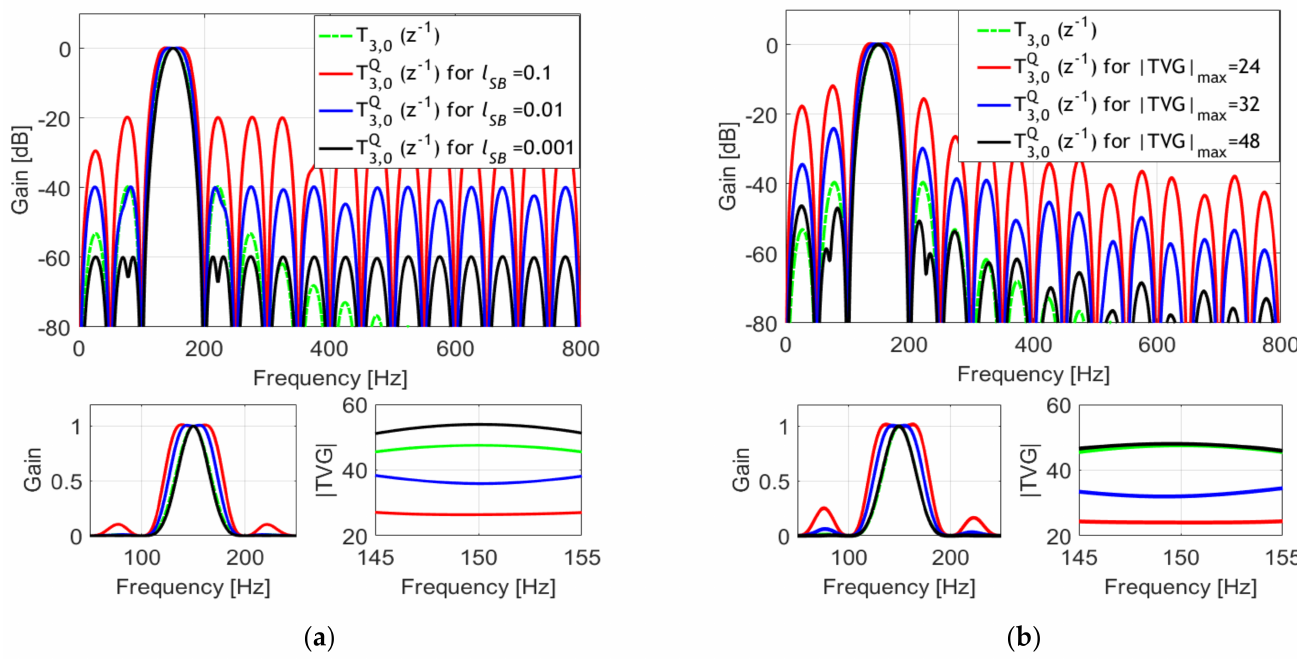
(cid:0) (cid:1) z − 1 ) and reshaped ( T Q ∈ { 24, 32, 48 } max